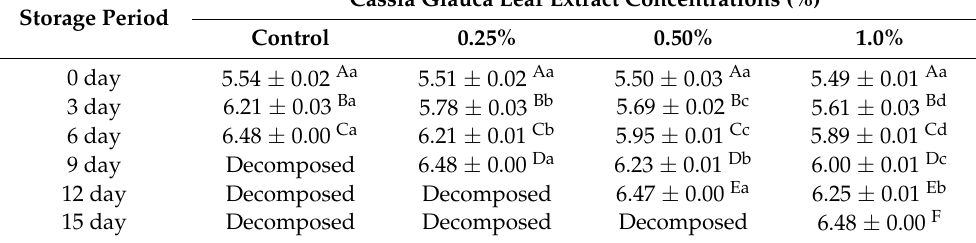
Table 7. Pattern of the psychrophilic count (log10 cfu/g) in minced beef treated with ethanolic Cassia glauca leaf extracts. (0.25%, 0.5%, 1%) during the cold storage period at 3 ± 1 ◦ C (mean ± standard deviation